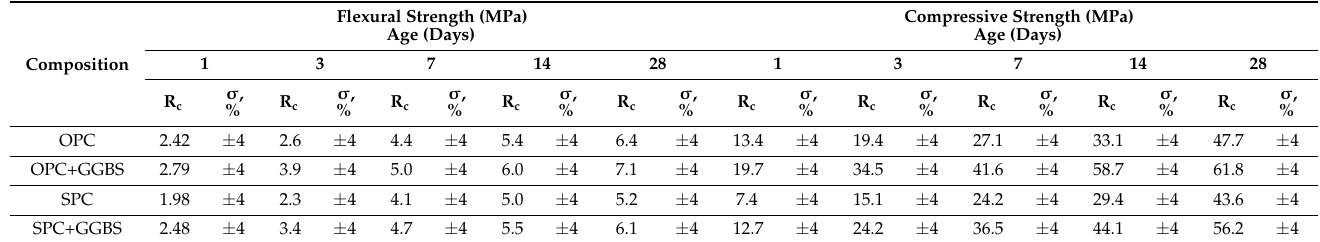
Table 27. Physical and mechanical characteristics of cement